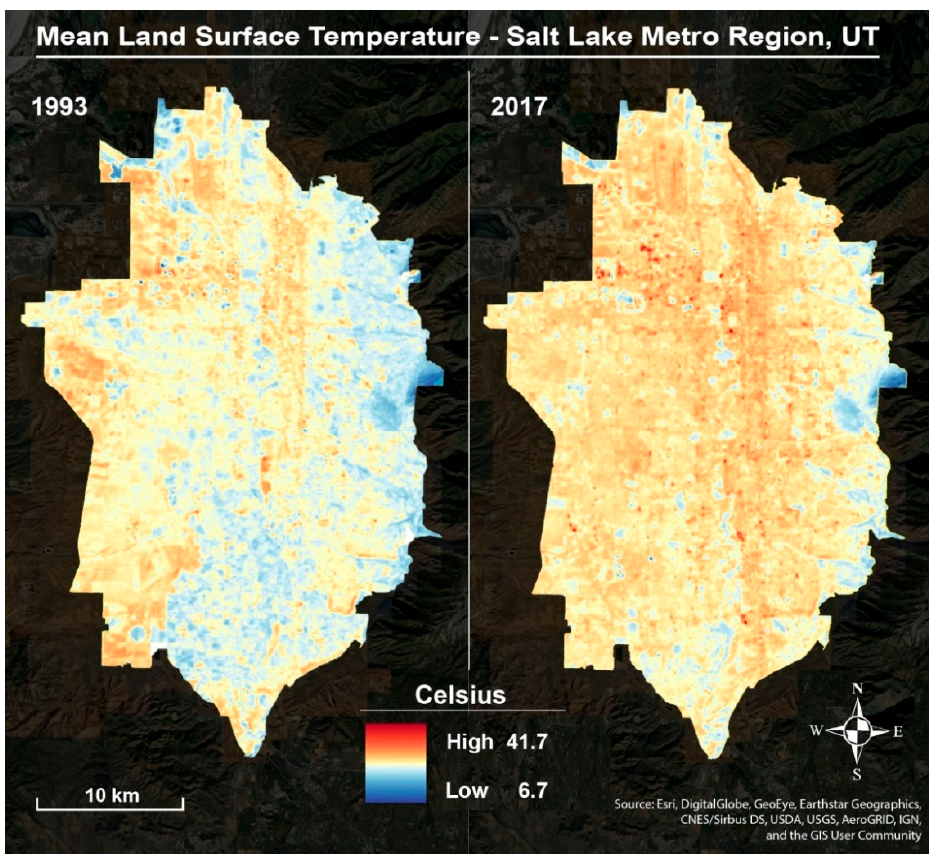
Figure A2. Assessment of different accuracy measures via bootstrapping. Remote Sens. 2019 , 11 , x FOR PEER REVIEW